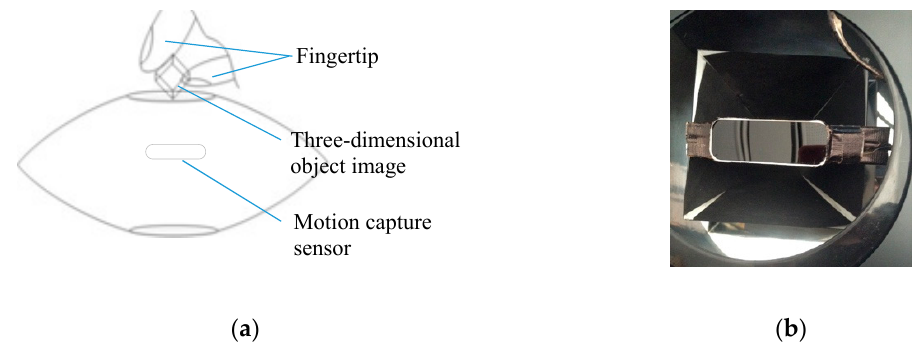
Figure 9. Setting of motion capture sensor: ( a ) longitudinal section; ( b ) top view.